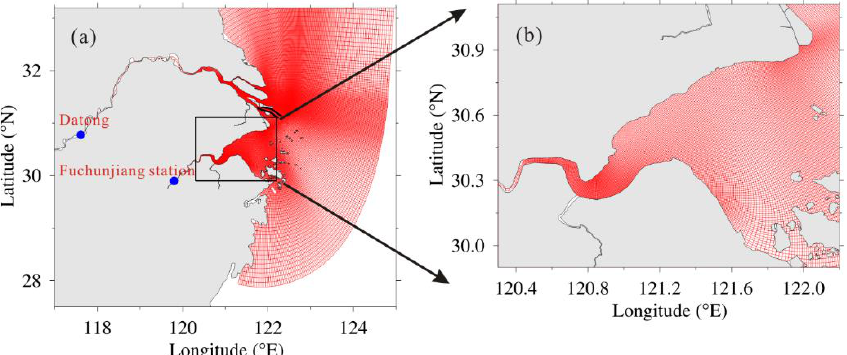
Figure 2. Numerical model domain and grid ( a ), and an enlarged view of the model grid in Hangzhou Bay ( b ).